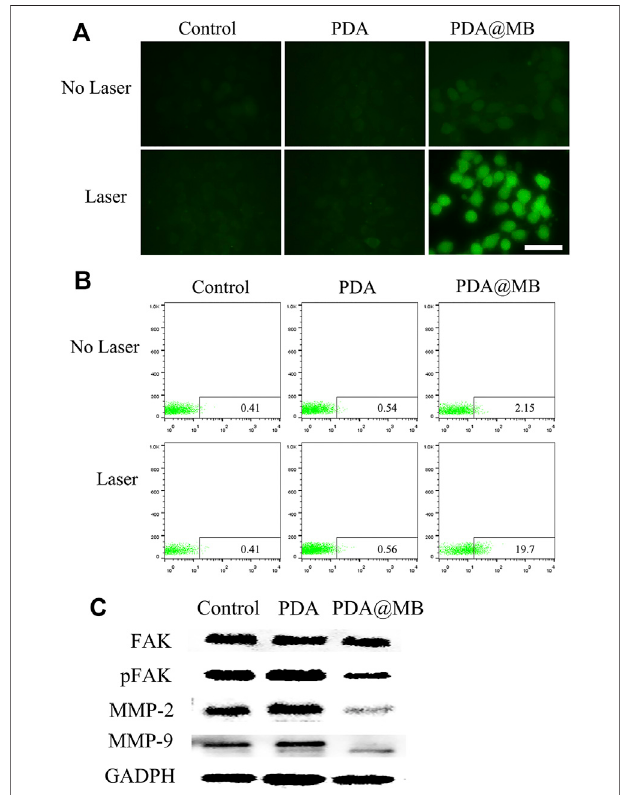
FIGURE4|(A) CLSMimages of4T1cellsafter incubation withPDAand PDA@MB in the absence or presence of NIR by DCFH-DA staining. The scale bar is50 μ m. (B) Quantitative fl owcytometry results. (C) The effect ofControl, PDA, and PDA@MB on the expression levels of FAK/MMP signaling pathway